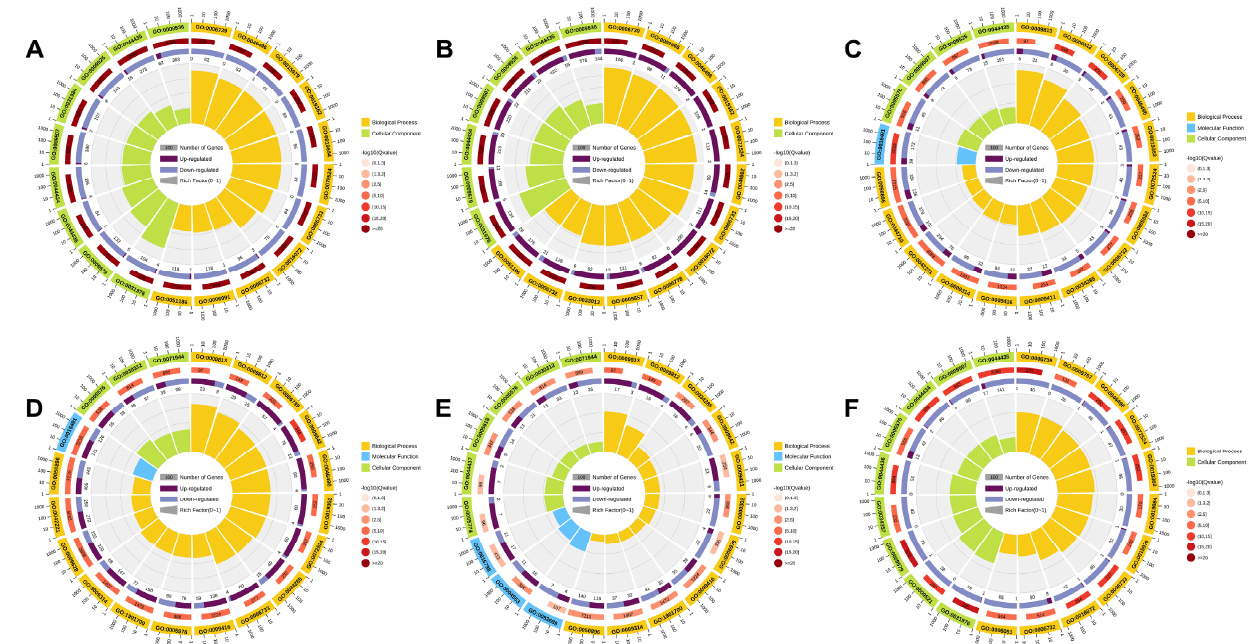
Figure 2. GO enrichment circle diagram of the six comparison groups. The first circle: enrichment of the first 20 GO terms; the coordinate ruler for the gene number is outside the circle. Different colors represent different ontologies. The second circle: the number and Q value of the GO term in the background gene. The more genes present, the longer the bar, the smaller the Q value, and the redder the color. The third circle: bar chart of the proportion of upregulated genes; dark purple represents the proportion of upregulated genes, and light purple represents the proportion of downregulated genes. Specific values are shown below. The fourth circle: Rich Factor value of each GO term (the number of different genes in the GO term divided by all the numbers) and background grid lines, where each grid represents 0.1 (( A ) comparison group CK1-P vs. T1-P; ( B ) comparison group T1-P vs. T2-P; ( C ) comparison group CK1-NP vs. T1-NP; ( D ) comparison group T1-NP vs. T2-NP; ( E ) comparison group T1-P vs. T1-NP; and ( F ) comparison group T2-P vs.